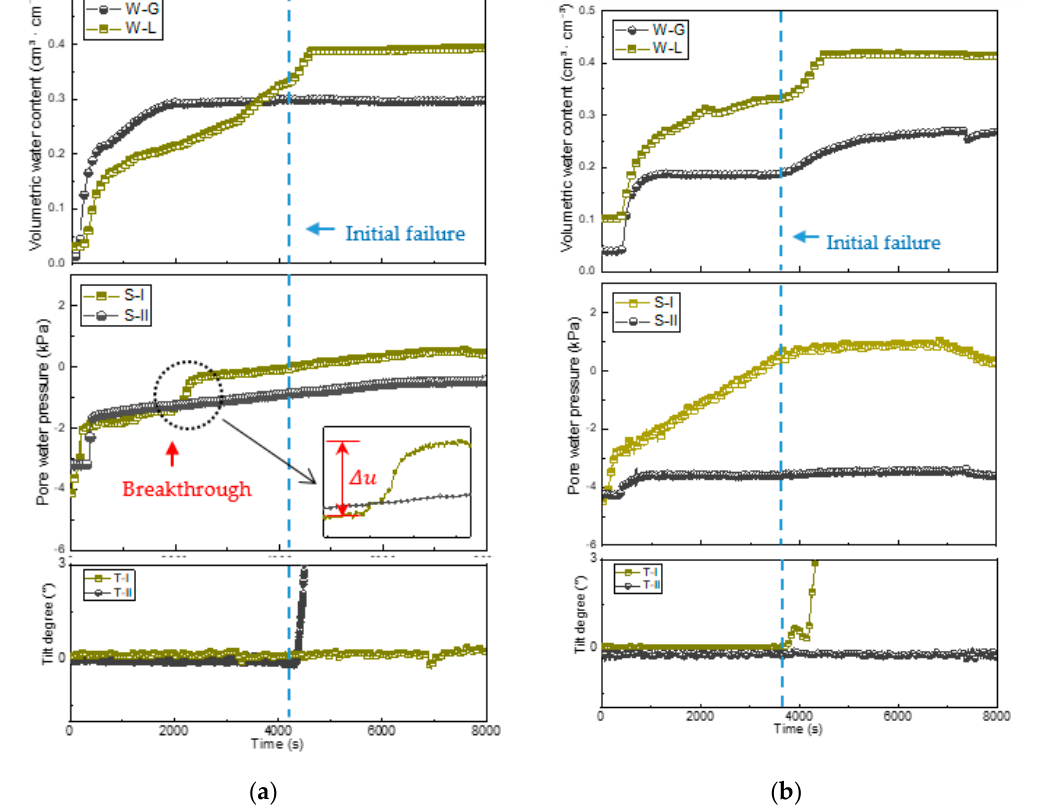
Figure 10. Volumetric water content, pore water pressure, and tilt angle change trends at different locations during infiltration. ( a ) case I (tilt angle α = 0°, multi-layer), where the pore water pressure increased after capillary barrier breakthrough; ( b ) case V (tilt angle α = 0°, single layer). For the positions of sensors, see Figure 3b.